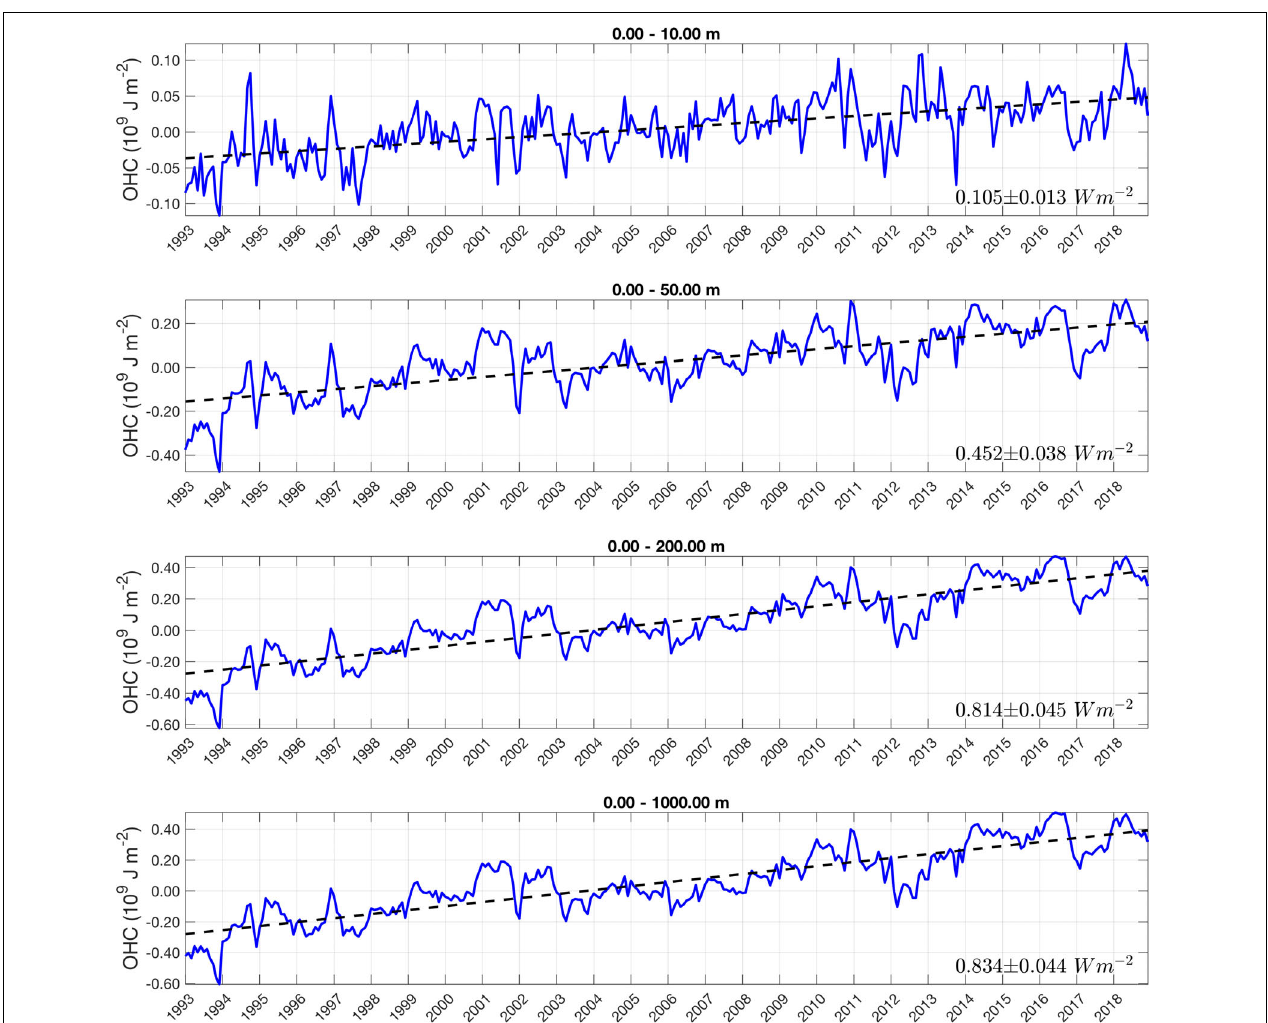
FIGURE 10 | Monthly basin-averaged of the ocean heat content anomalies (in 10 9 J m − 2 ) estimated for the BS-REA. The monthly ocean heat content anomalies are defined as the deviation from the climatological ocean heat content mean (1993–2014) of each corresponding month. Mean trend values are also reported in the figures (bottom right corner).